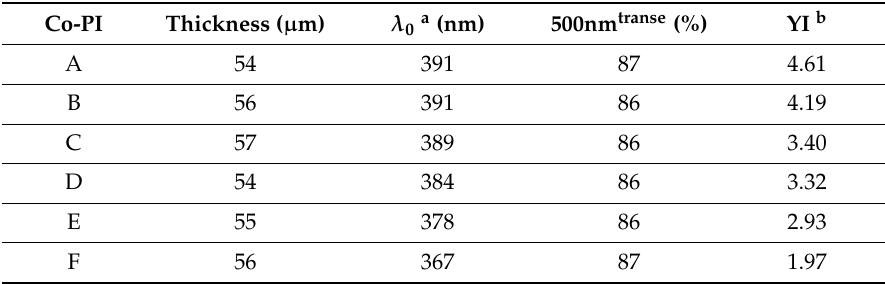
Table 4. Optical properties of the Co-PI films.